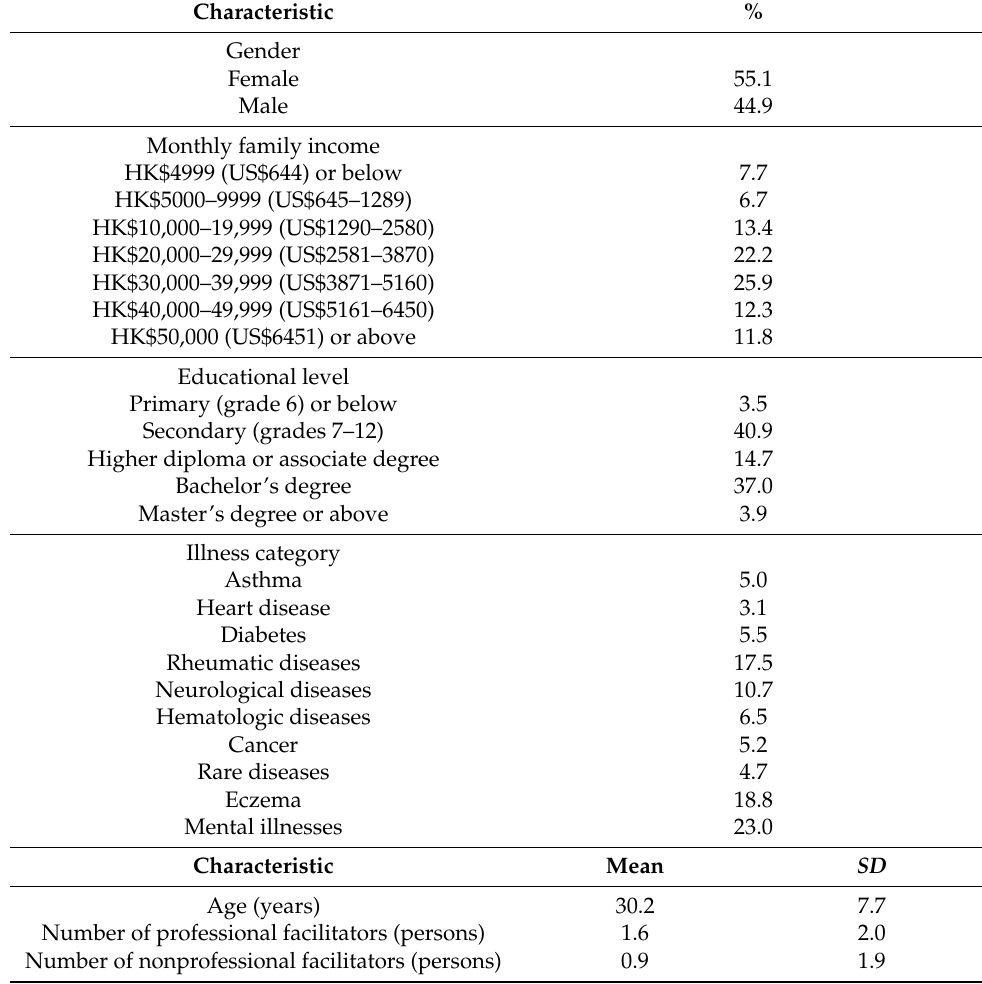
Table 1. Background characteristics of study participants ( N =